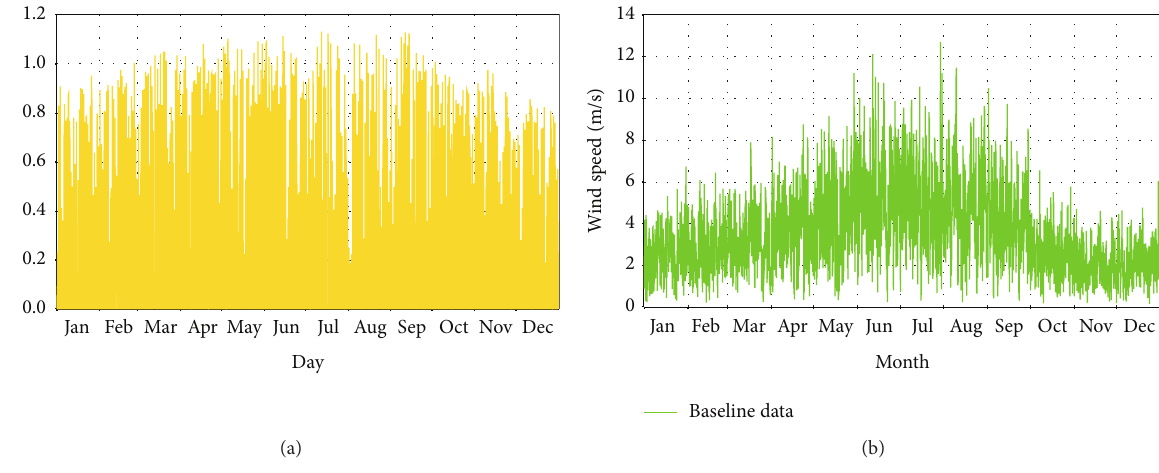
Figure 11: Yearly resources. (a) Global horizontal radiation. (b) Wind